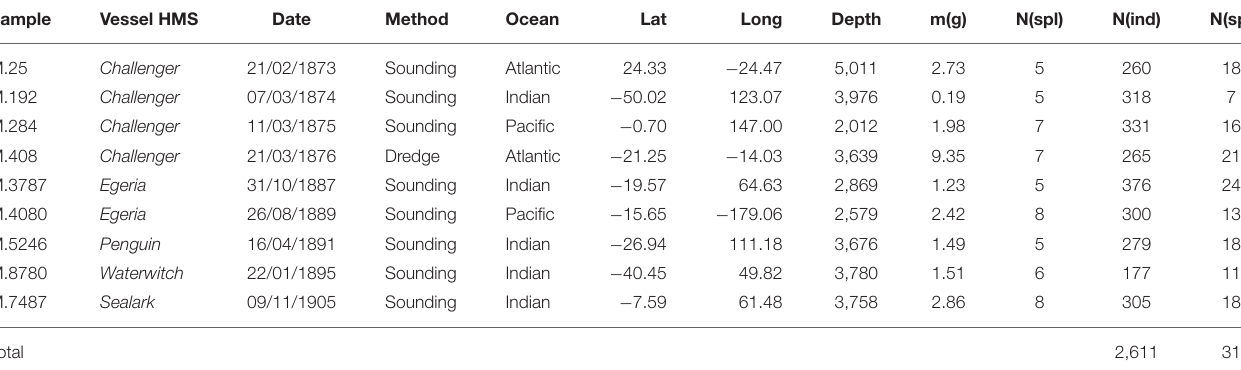
TABLE 1 | Information about the historical sediment samples from the Ocean Bottom Deposits (OBD) Collection at The Natural History Museum, London (NHMUK).